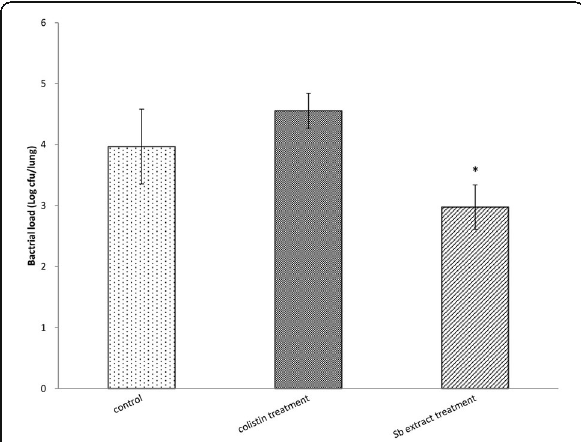
Fig. 5 Bacterial load in the lungs of the infected mice without therapy (control group) and infected mice treated with colistin or S. barbata (Sb) extract after inoculation with 3.97±0.61, 4.56±0.28 and 2.97± 0.36 log CFU/lung (Data are expressed as the mean±SD of five mice for each group). “ * ” Significantly lower bacterial load in the S. barbata (Sb) extract treatment group compared to the control group ( P